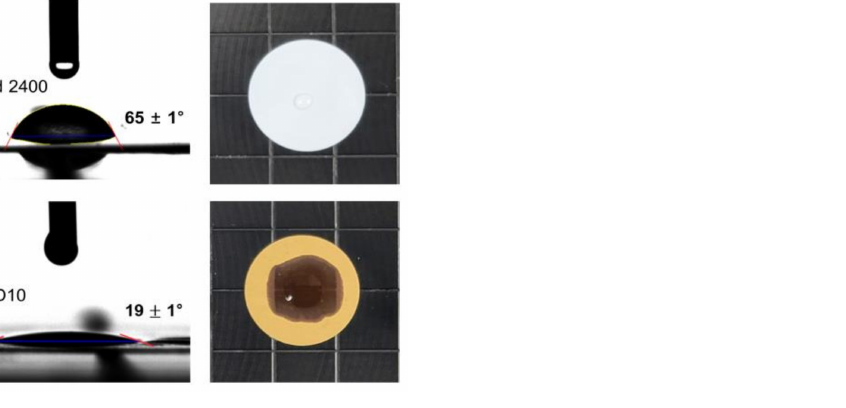
Figure 5. Images of the contact angle and wettability between the membrane and LE: ( a ) Celgard 2400 and ( b ) PAN/AD10.